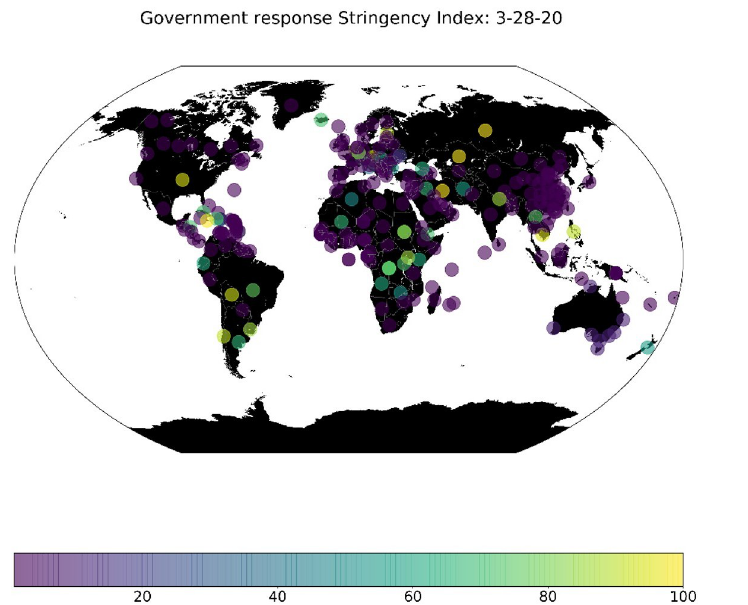
Fig 6. Shows an example for the stringency index globally for